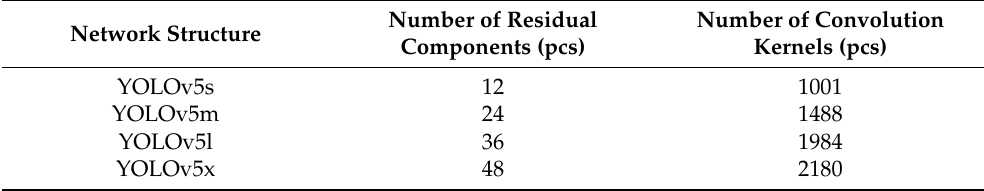
Table 1. YOLOv5’s four network structure differences.